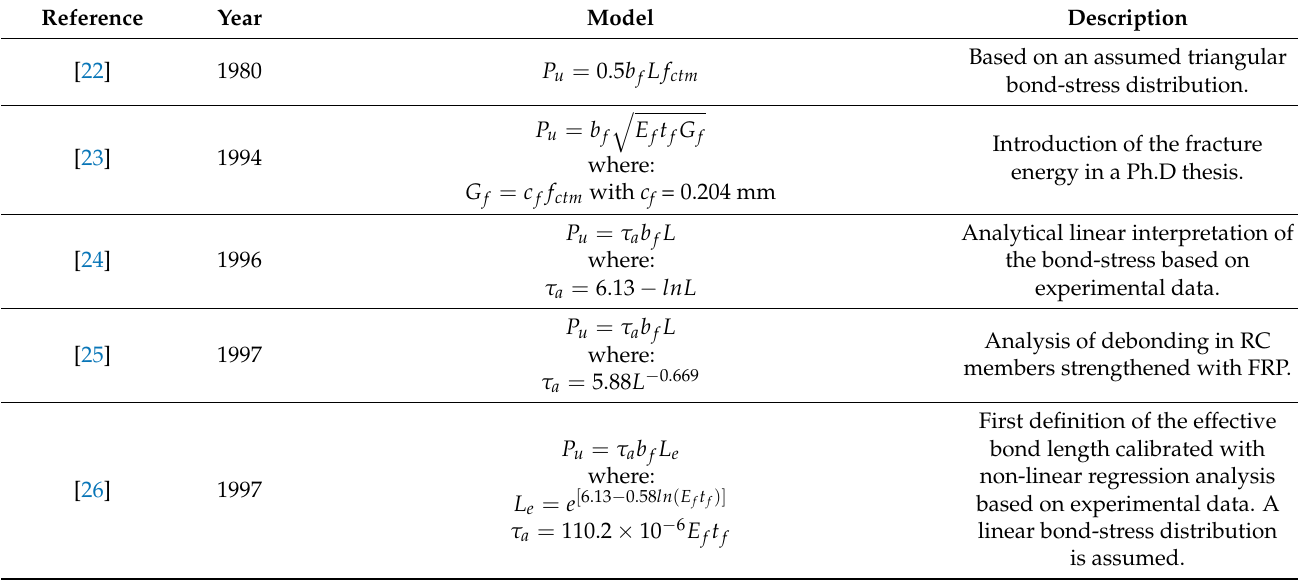
Figure 1. Sketch of the pull-pull shear test setup. Table 1. Analytical models for the prediction of the bond strength between FRP and